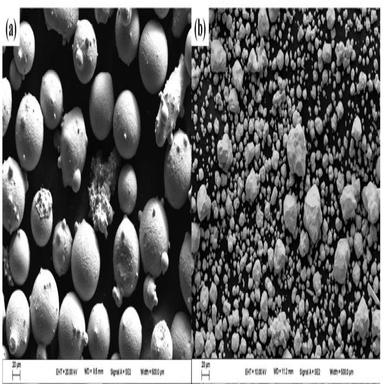
Powder morphology for a) prealloyed CoCrFeMnNi and b) W powders.